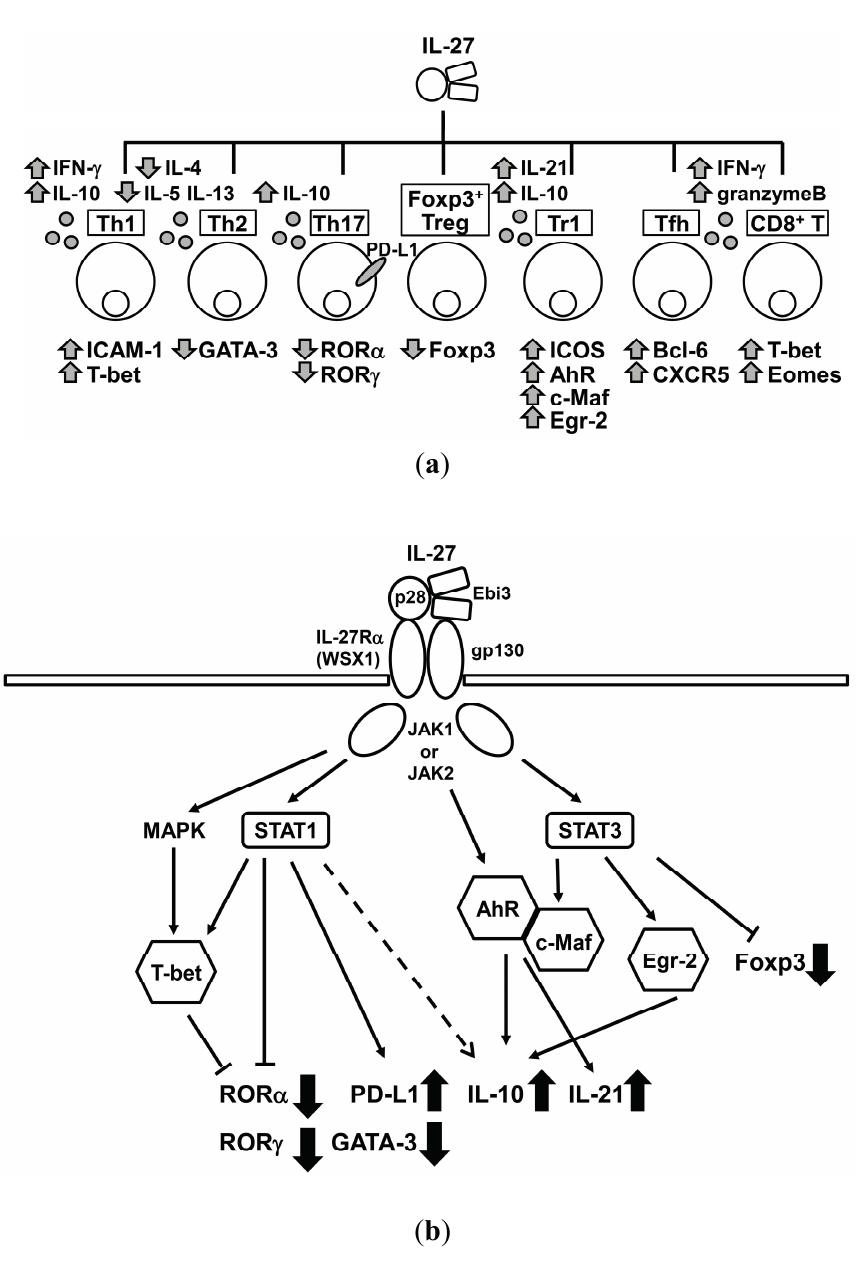
Figure 1. ( a ) Overview of the interleukin (IL)-27 effect on various T cell subsets; and ( b ) IL-27 signal transduction in T cell. Expressions of retinoid-related orphan receptor (ROR) α , ROR γ , GATA binding protein-3 (GATA-3), and forkhead box protein P3 (Foxp3) are suppressed by IL-27. IL-10 and programmed death ligand 1(PD-L1) expressions are enhanced. Binding of signal transducer and activator of transcription (STAT) 1 on IL-10 promoter is unclear. IFN- γ , interferon- γ ; ICAM-1, intercellular adhesion molecule-1; ICOS, inducible co-stimulator; AhR, aryl hydrocarbon receptor; c-Maf, musculoaponeurotic fibrosarcoma oncogene homolog; Egr-2, early growth response protein 2; Bcl-6, B-cell lymphoma 6; T-bet, T-cell-specific T-box transcription factor; Eomes, eomesodermin; CD8 + , cluster of differentiation 8 positive; CXCR5, C-X-C chemokine receptor 5; Tr1, type 1 regulatory T; Tfh, follicular helper T; JAK, Janus kinase; MAPK, mitogen-activated protein